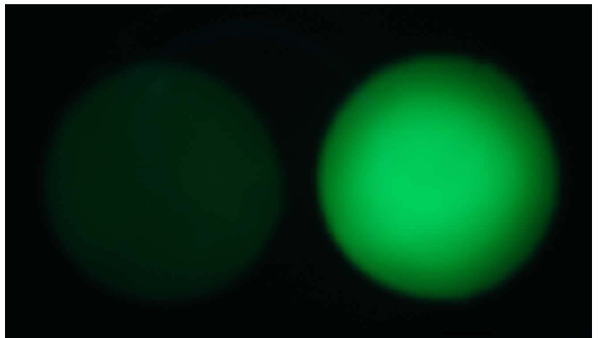
Figure 2. Germination-dependent fluorogenicity of F-spores. Image of two side-by-side glass fiber disks (6.35-mm diameter) each containing about 2.5 6 10 7 F-spores of B. megaterium constructed with diacetylfluorescein. Left: Dormant F-spores. Right: F-spores exposed to germinant (4 mM D-glucose). Disks were prepared as indicated in Materials and Methods, and their fluorescence images were captured